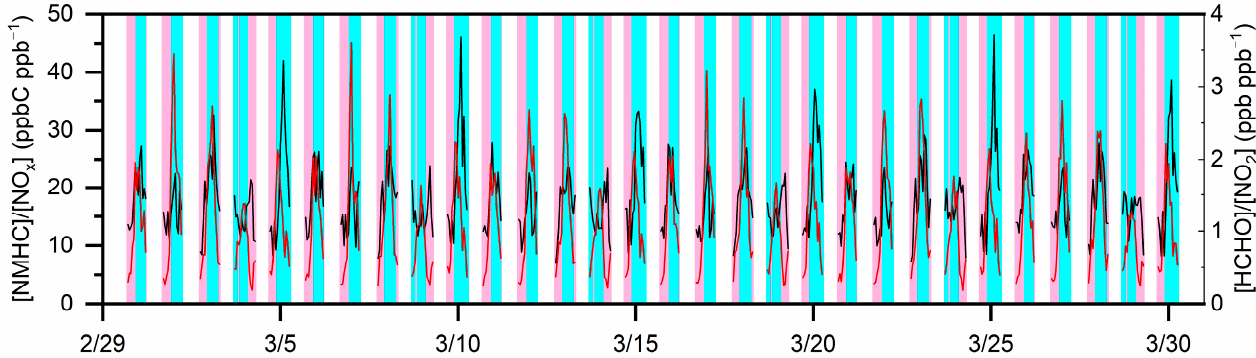
Figure 5. Temporal changes in [NMHC]/[NO x ] and [HCHO]/[NO 2 ] from 1 March to 30 March, 2020 (UTC).